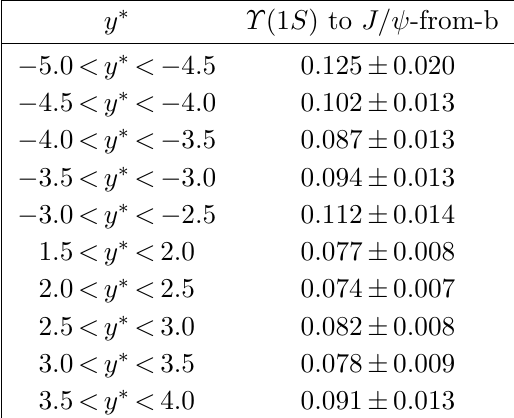
Table 20 . (cid:7) (1 S ) to nonprompt J= , in p Pb and Pb p as a function of y (cid:3) integrated over p T in the range 0 < p T < 25 GeV =c . The quoted uncertainties are the sum in quadrature of the statistical and systematic